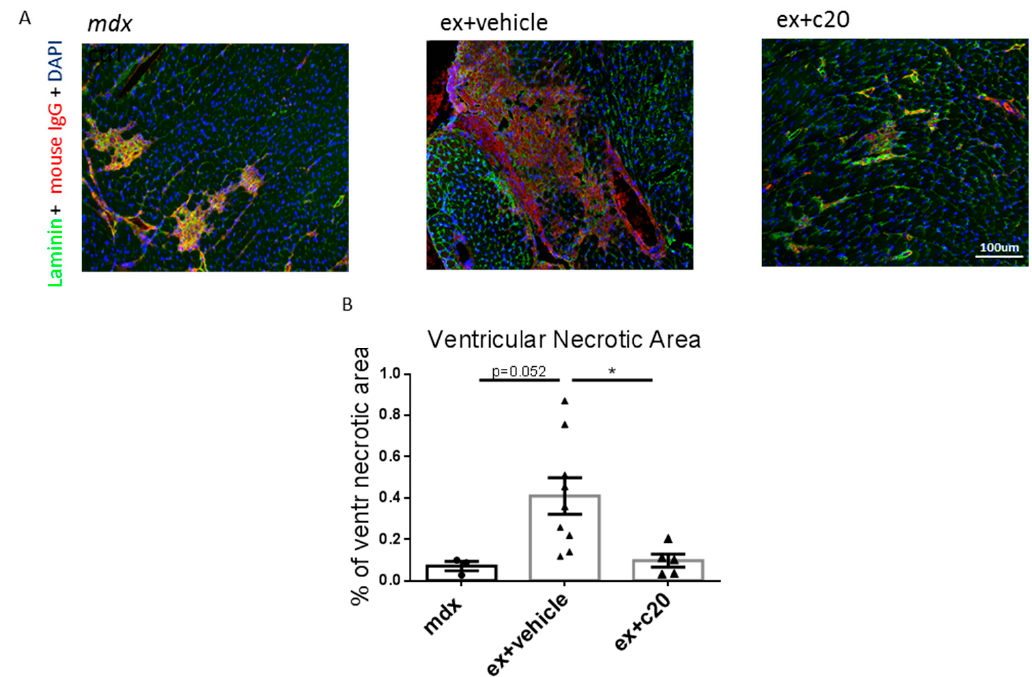
Figure 4. Decreased cardiomyocytes necrosis in C20-treated exercised mdx ventricles. ( A ) Representative images showing ventricular necrosis in control mdx and vehicle or C20-treated exercised mdx , as detected by anti-mouse IgG staining. ( B ) Quantification of the ventricular necrotic area expressed as percentage over the total ventricular area, calculated using ImageJ software. Data are shown as mean +/ − S.E.M, n = 3, 7, 5 independent samples per group. * p < 0.05, ordinary one-way ANOVA with Bonferroni correction for multiple comparisons.